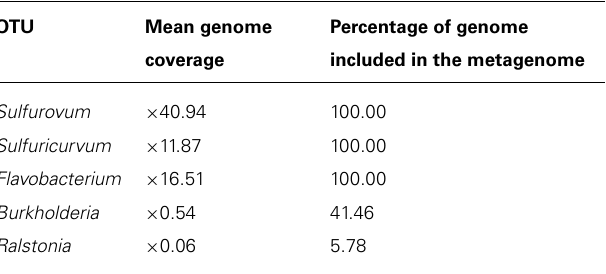
Table 4 | Estimated mean genome coverage, and percentage of genome included in the metagenome library, for the five most abundant species-level OTUs.The OTUs are the same as those shown in Figure